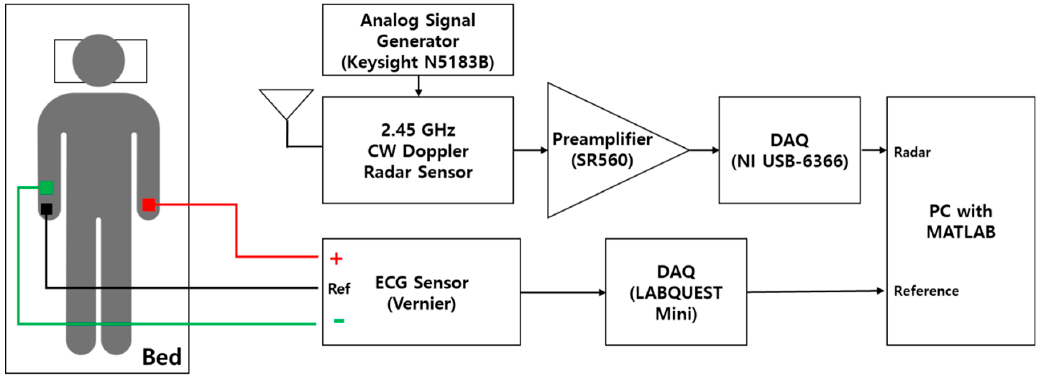
Figure 6. Measurement environment for vital signs monitoring.